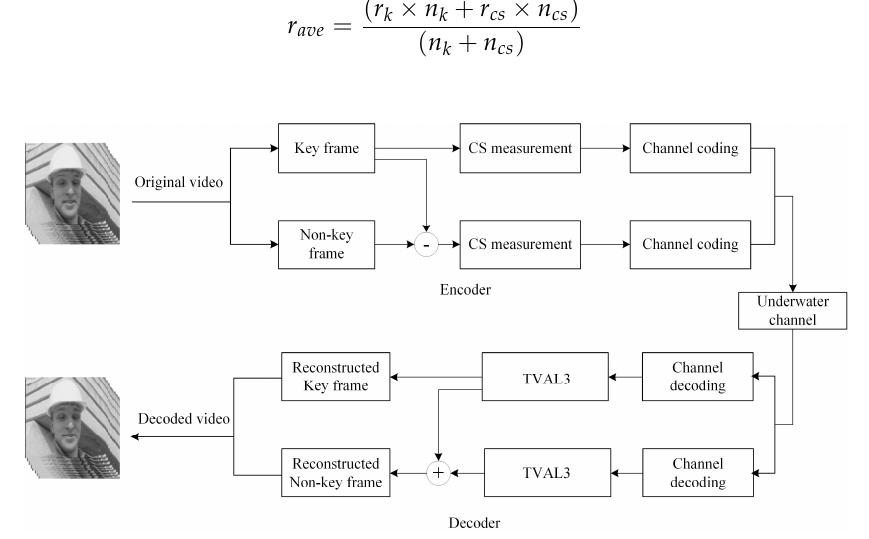
Figure 1. Joint source-channel coding scheme based on residual distributed compressive video sensing.